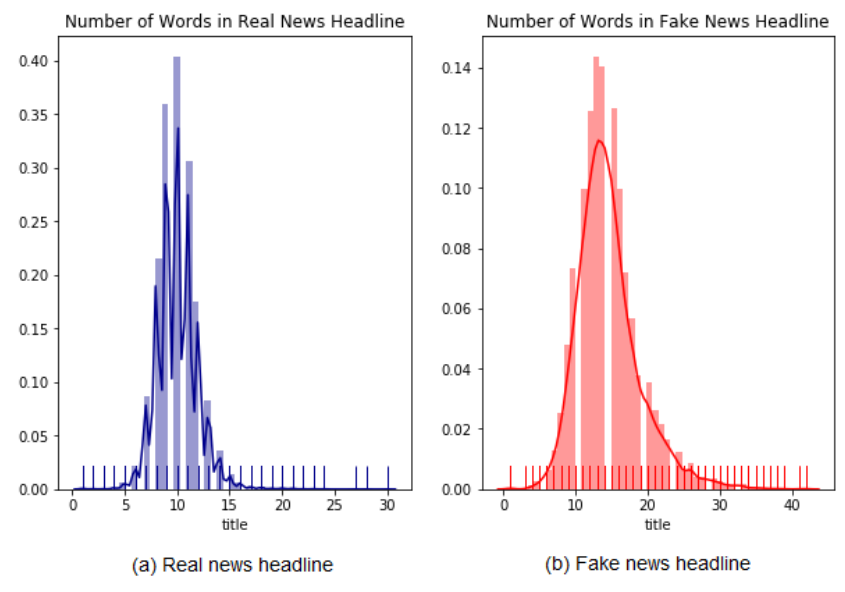
Figure 11. The distribution of Real and Fake news headlines